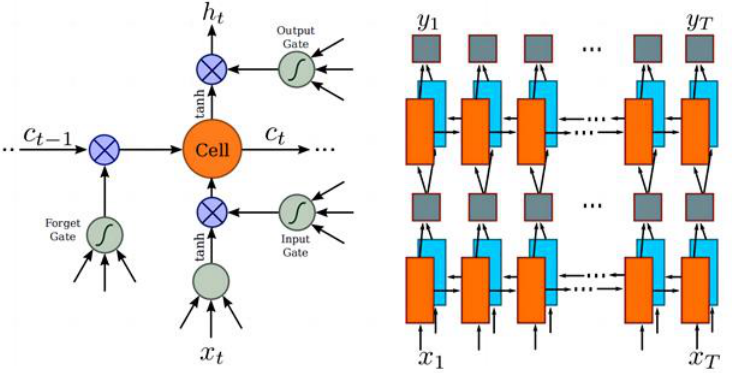
Figure 7. Deep bidirectional recurrent network structure.